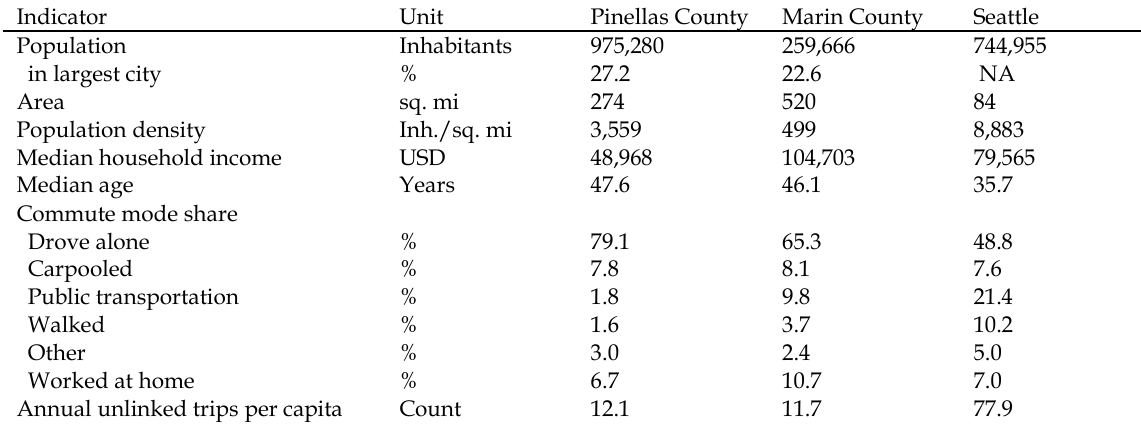
Table 1. Summary of case studies and regional